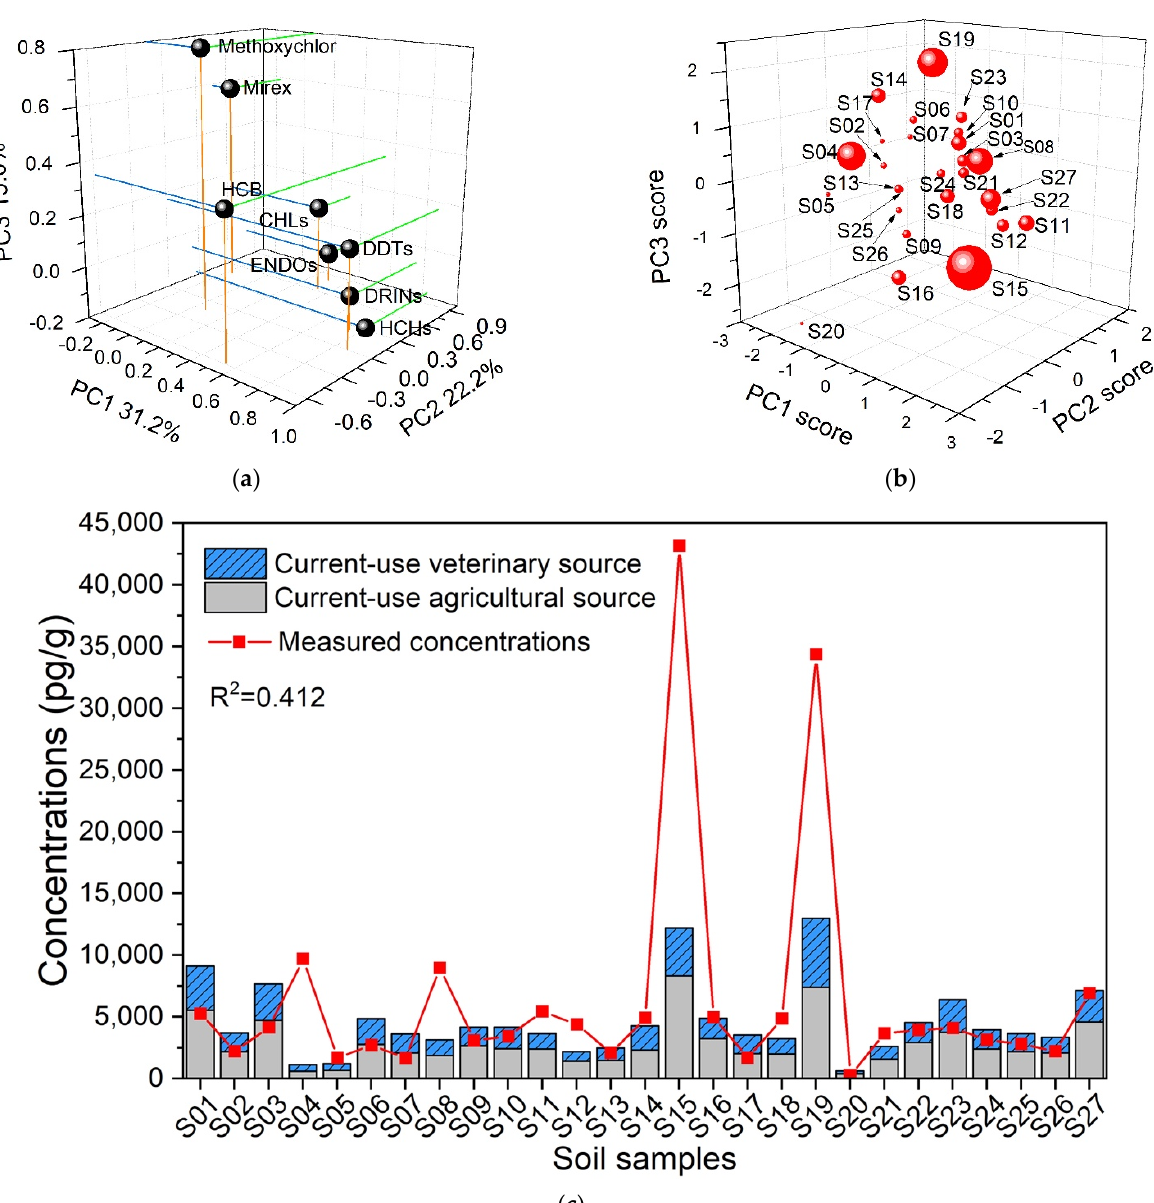
Figure 5. Loading profiles of PCs ( a ), factor scores of each soil samples ( b ), and contributions of current-use agriculture source and current-use veterinary source to the ∑ 25 OCP concentrations in each soil samples ( c ), based on the PCA + MLRA analysis. PC1, PC2, and PC3 in ( a ) indicate the current agricultural use, historical agricultural use, and current veterinary use, respectively. The point sizes in ( b ) represent the concentration levels of ∑ OCPs. The poor fits between modeled concentrations and measured concentrations in Sites S15 and S19 in ( c ) indicate the existence of other dominant pesticide sources (e.g., agrochemical waste dumps).